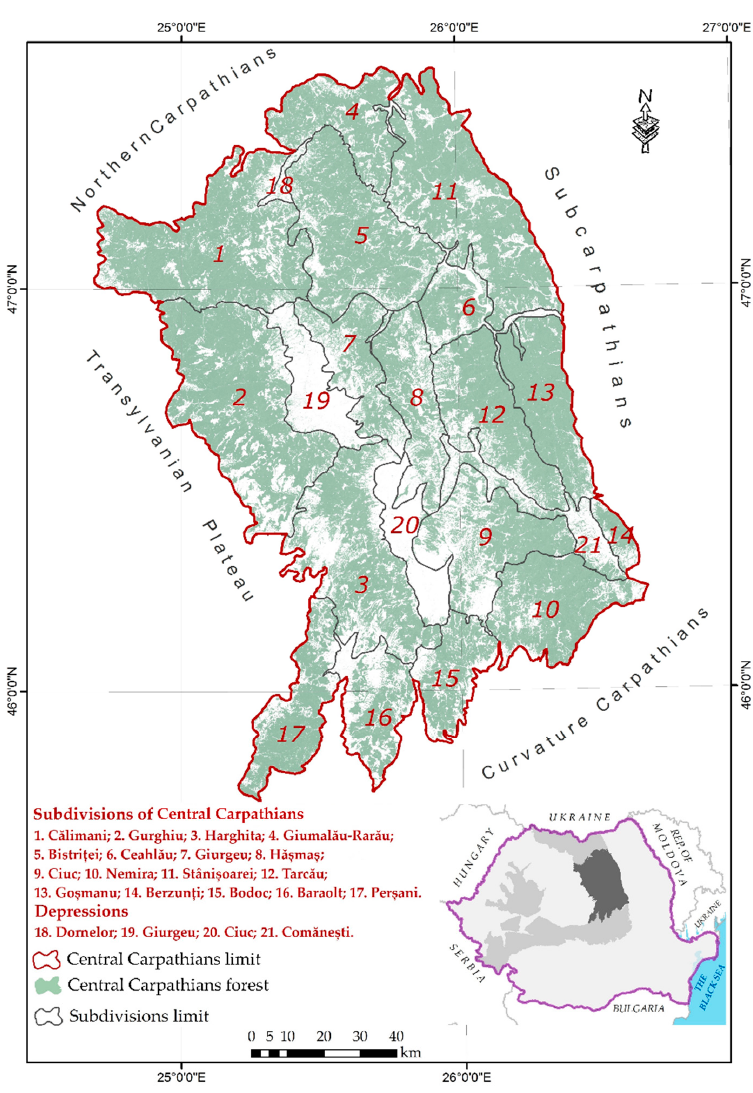
Figure 1. The geographical study area of the Central Carpathians in Romania.